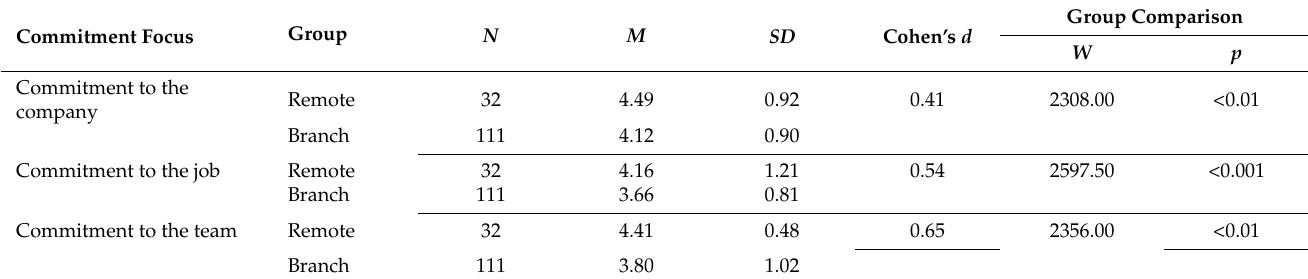
Table 5. Descriptive statistics and group comparisons on the commitment